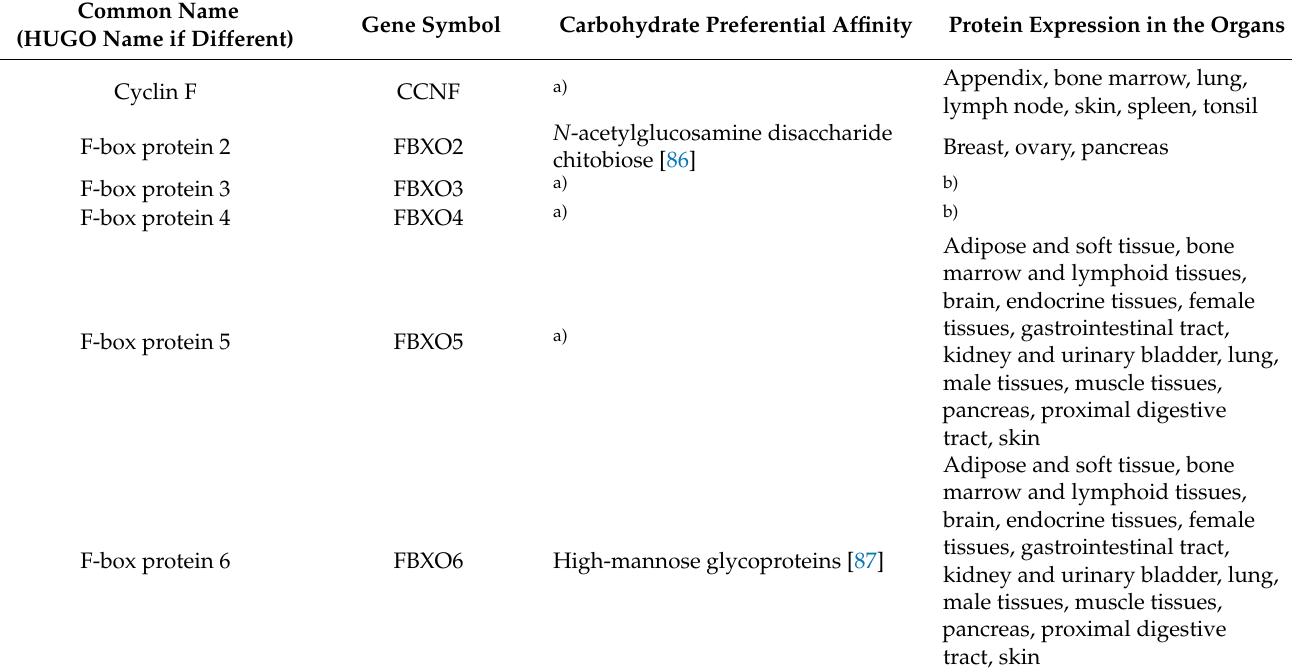
Table 4. Human F-box lectins, their carbohydrate ligands and protein expression in the